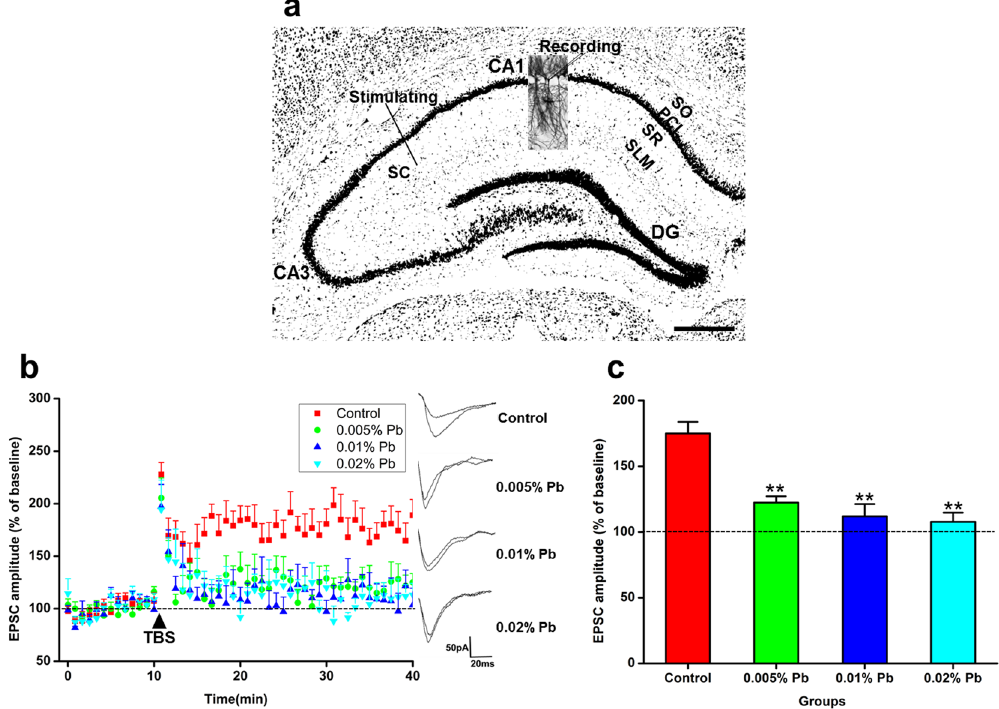
Figure 2. Pb accumulated in the hippocampus and impaired CA3-CA1 LTP of Pb-exposed PND30 rats. ( a ) Simulations were applied to the SC regions of hippocampus and the signal was collected at the CA1 region. stratum oriens, SO; pyramidal cell layer, PCL; stratum radiatum, SR; stratum lacunosum-moleculare, SL-M; dentate gyrus, DG; schaffer collaterals, SC; scale bar: 500 μ m. ( b ) LTP in hippocampal regions CA3-CA1. Arrowhead indicates time of tetanic stimulation. The EPSC amplitude showed a negative correlation between Pb exposure and LTP. N = 16 slices of 8 rats for all groups. ( c ) EPSCs were measured as percentage of baselines, respectively. Statistical analysis of LTP at PND 30 showed that GLE rodents exposed to 0.02% Pb showed the lowest EPSC amplitude. Data are expressed as mean ± SD, ** p <